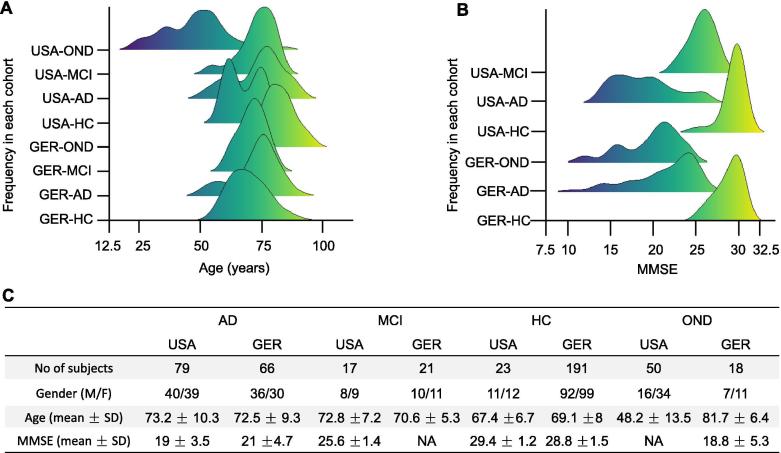
Distribution of age, gender, diseases, and MMSEA. Histogram for the age distribution in the different cohorts. The diagram shows for each cohort/disease the age distribution. Only the OND group from the US shows a deviation towards younger patients, while all other groups have similar age ranges. B. Histogram for the MMSE values. HCs and MCI patients show significantly larger MMSE values as compared to AD and OND patients. C. Metrics. For each of the cohorts and diseases, the number of patients in the US and Germany, the mean and SD for age and MMSE as well as the gender distribution are provided. GER, Germany; MMSE, Mini-Mental State Examination; AD, Alzheimer’s disease; OND, other neurological diseases; HC, healthy control; MCI, mild cognitive impairment.